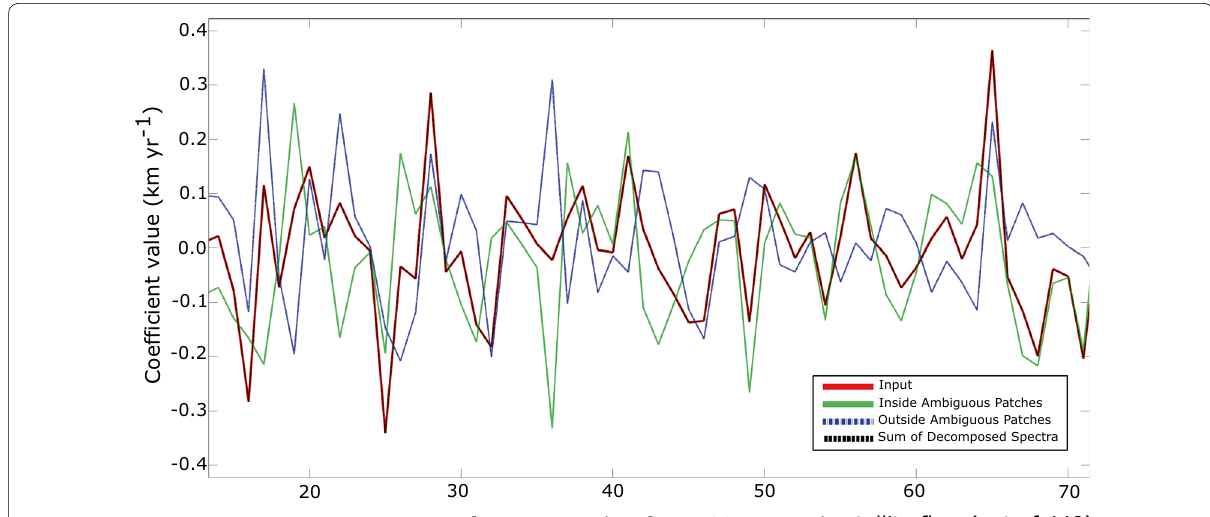
Fig. 9 Example of coefficient splitting from tangentially geostrophic ambiguous patch for inverted satellite data flows. An example of coefficient values for the input, inside tangentially geostrophic ambiguous patches, the complementary outside region and the summed coefficients of the decomposition for the Shannon number of the inverted satellite data. The input and summed values are exactly the same for each coefficient, but there are some coefficients which separate into much larger absolute values than their corresponding input